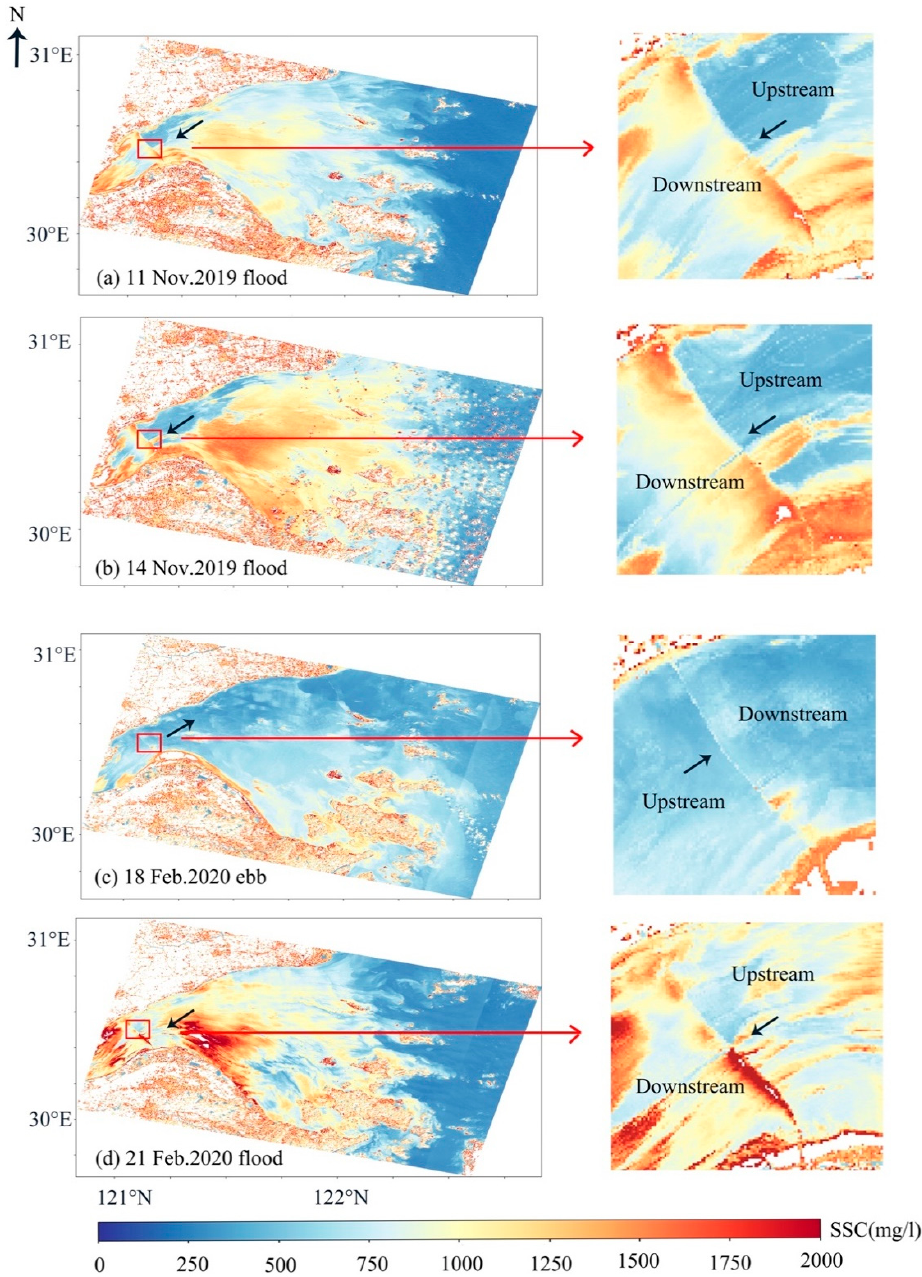
Figure 8. Suspended sediment concentration retrieved from HY-1C data collected on 11 ( a , b , d ) Flood; ( c ) ebb.